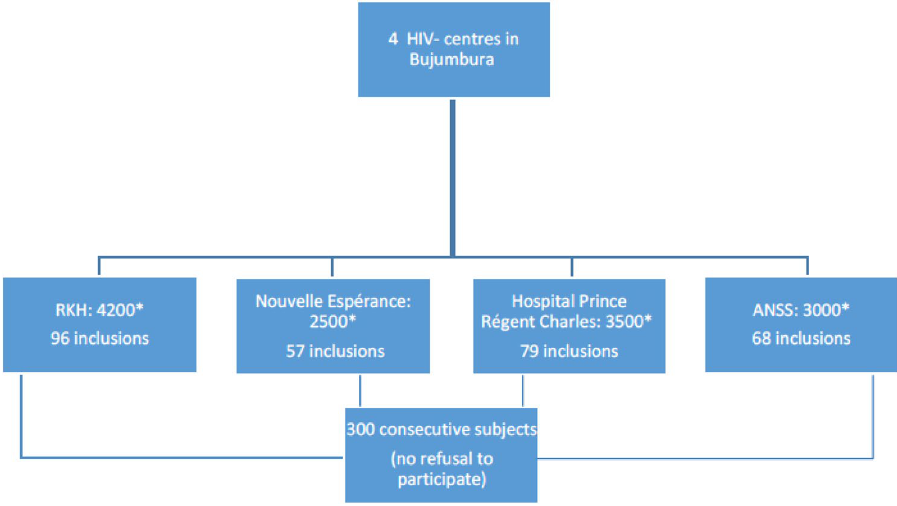
Figure 1. Flow chart. ANSS Burundi National Association for people living with HIV, RHK Roy Khaled Hospital, *followed HIV infected subjects/year.